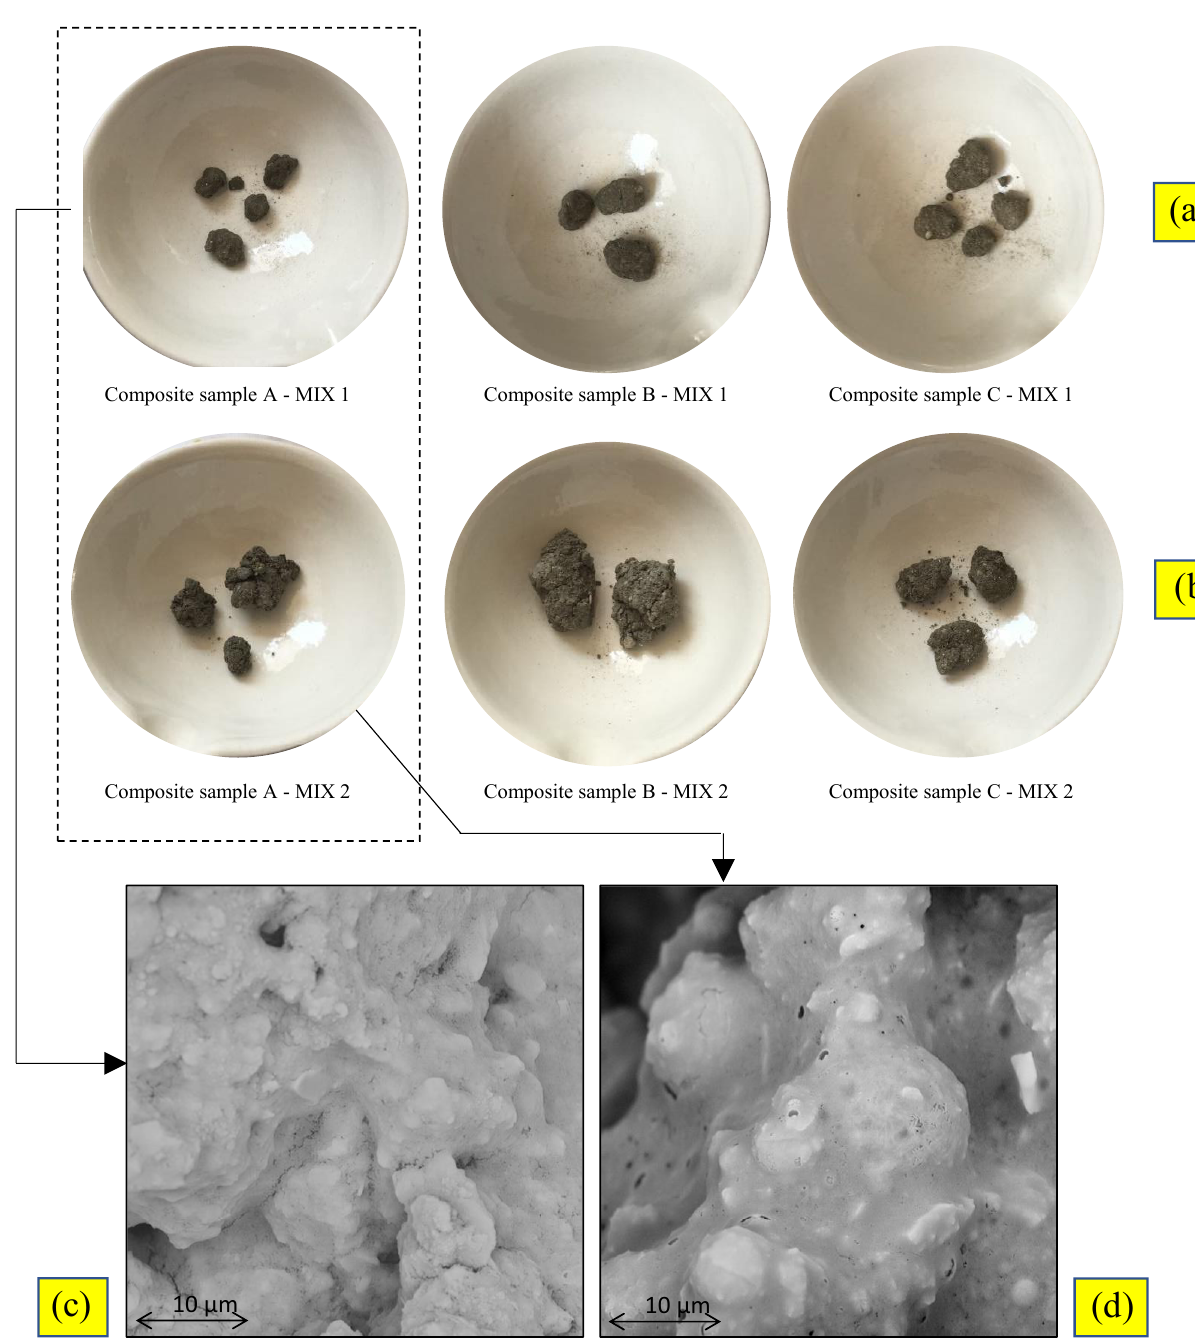
Figure 5. Granules performed by the S/S treatments with mixtures 1 ( a ) and 2 ( b ); SEM images of sample A treated by mixtures 1 ( c ) and 2 ( d ).